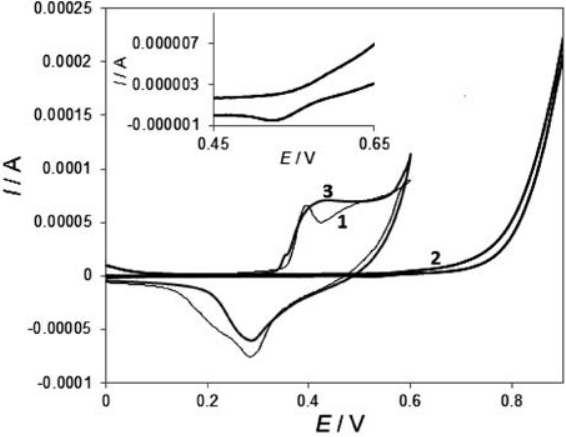
Figure 2. Cyclic voltammogram of (1) Ni, (2) Cu and (3) Ni-Cu electrode oxidation in 1 M NaOH at a scan rate of 10 mV s –1 . Unset: Cyclic voltammogram of Cu electrode in the potential range of 0.45 and 0.65